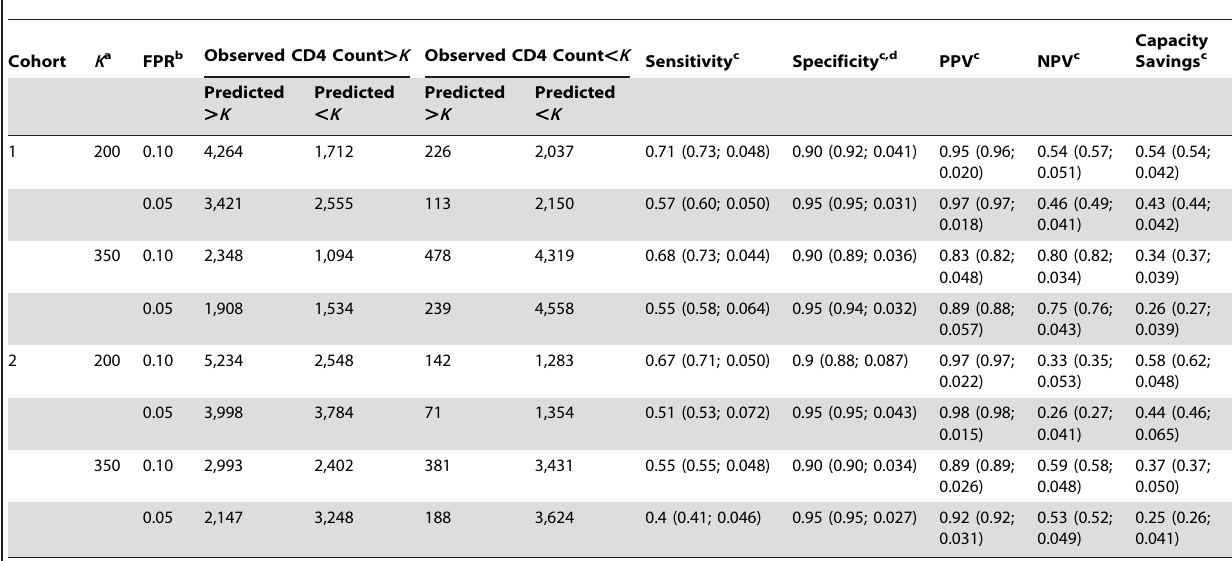
a K: CD4 + T cell count threshold (cells/ m l). b FPR, assigned. c Re-substitution estimate (mean CV estimate; SD of cross-validated estimates). d Fixed, as determined by FPR. NPV, negative predictive value; PPV, positive predictive value.